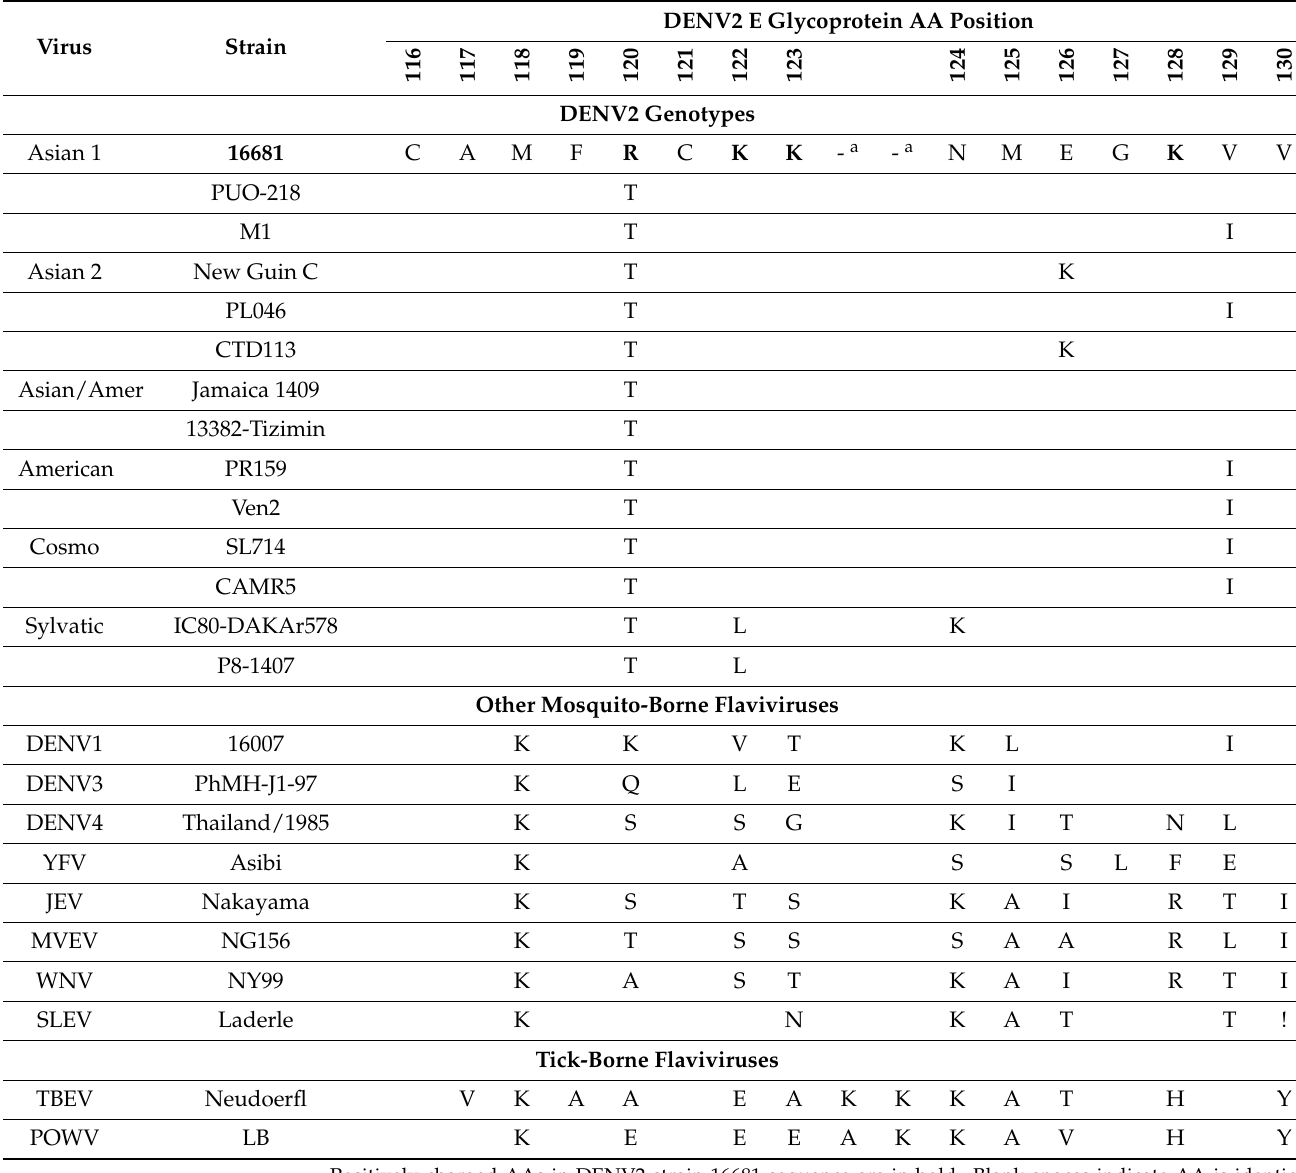
Table 2. E protein DII AA sequence alignment of DENV2 and other flaviviruses.